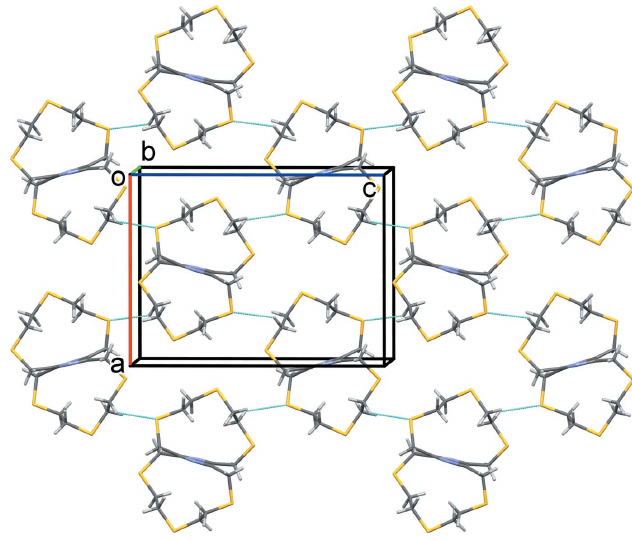
Figure 4 A view along the b axis of the crystal packing of II , with the C—H (cid:2)(cid:2)(cid:2) S hydrogen bonds (Table 2) shown as dashed lines.